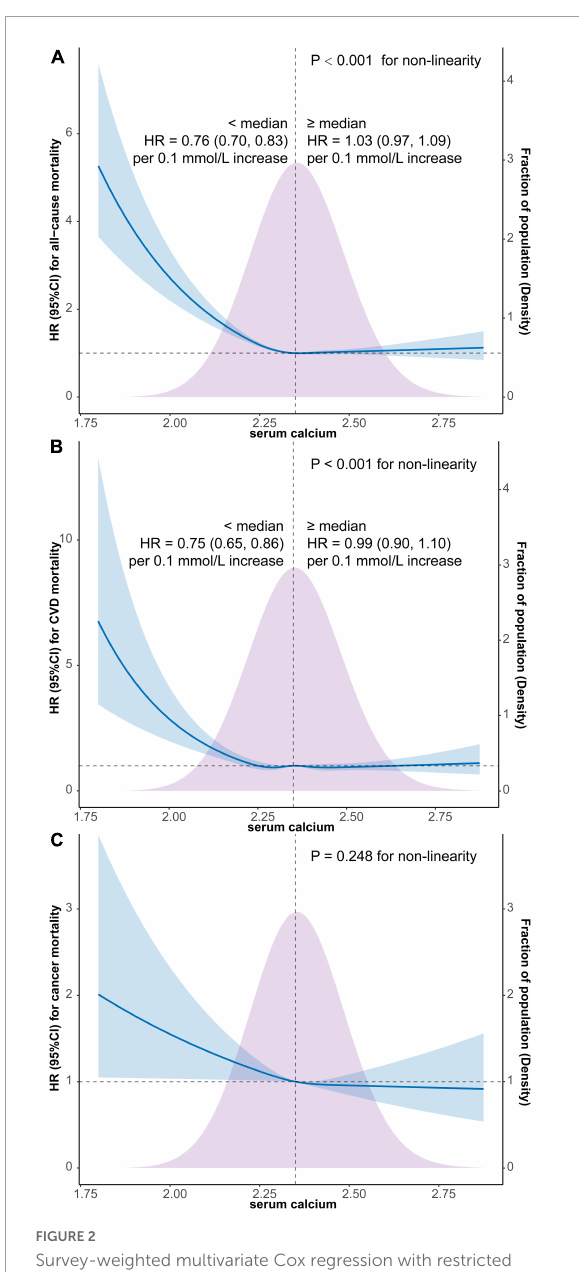
FIGURE2 Survey-weighted multivariate Cox regression with restricted cubic spline analyses of the associations of continuous serum calcium level with all-cause mortality (A) , CVD mortality (B) , and cancer mortality (C) and segmented weighted Cox regression on both sides of the reference value. The models were all adjusted for sex, age, race, education, marital status, PIR, BMI, smoking, alcohol use, caffeine consumption, dietary calcium intake, HEI-2015, physical activity, comorbidity or history of hypertension, diabetes, CHD, stroke, COPD, cancer, and CKD. Solid blue lines are multivariable-adjusted HR estimations and the shaded areas are the corresponding 95% CIs. The violet-shaded area indicates the distribution of the population with different levels of calcium. HR, hazard ratio; CI, confidential interval; CVD, cardiovascular disease; BMI, body mass index; PIR, family income-to-poverty ratio; HEI, healthy eating index; COPD, chronic obstructive pulmonary disease; CHD, coronary heart disease; CKD, chronic kidney